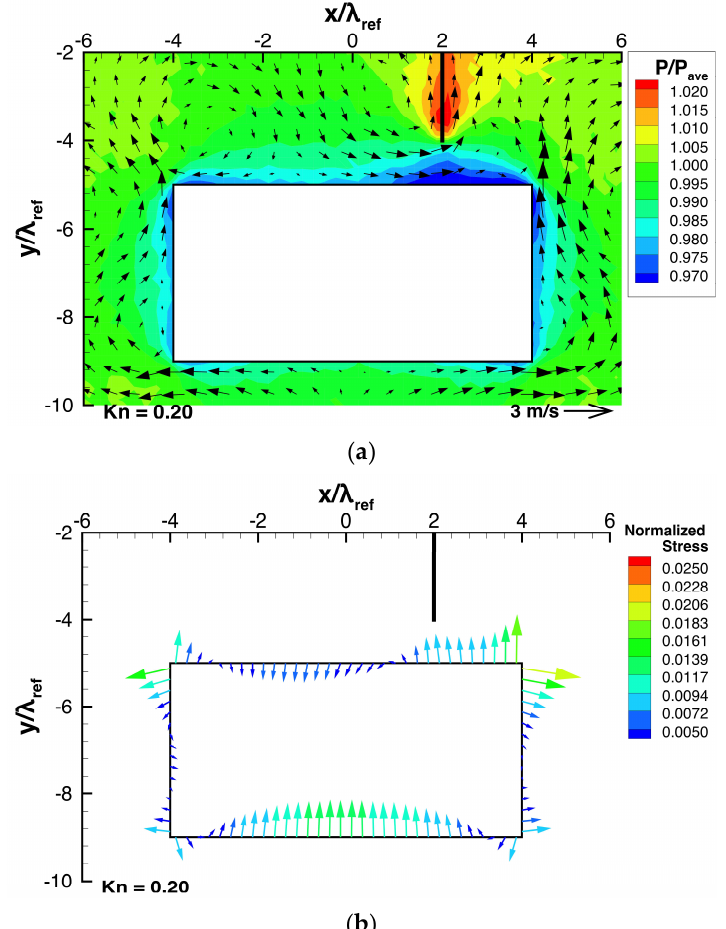
Figure 10. ( a ) Pressure and flow distributions around the beam and ( b ) stress distributions on the beam surfaces for a beam height of ℎ = 0.375𝑤 , at Kn = 0.2 .